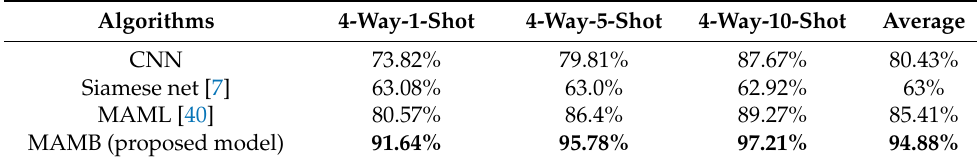
Table 2. Comparison of MAMB with different algorithms in the few-shot diagnosis of the CWRU data.